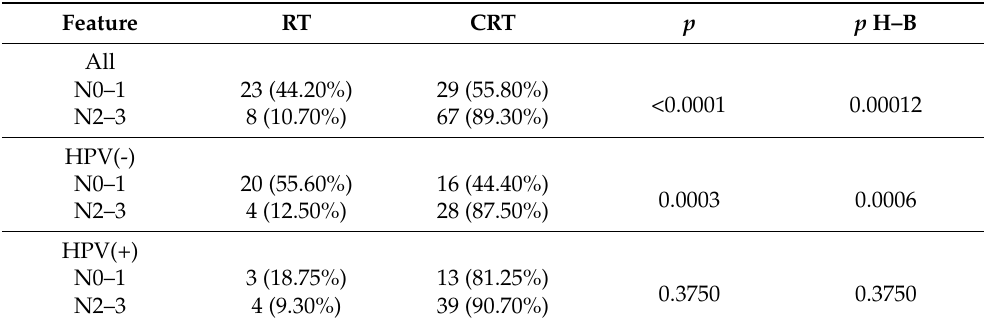
Table 2. Correlations between regional cancer stage (lymph node metastasis) and treatment type